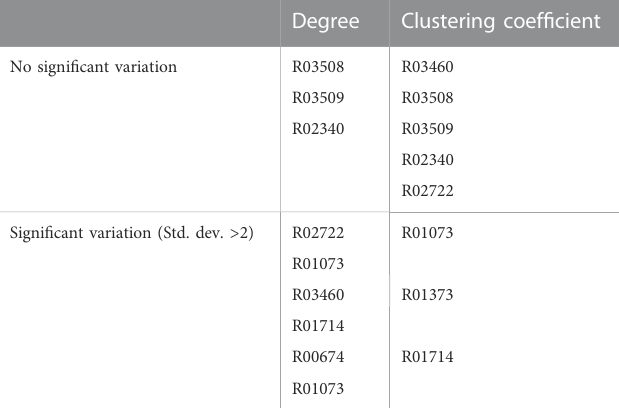
TABLE 1 Changes in Degree and Clustering Coef fi cient in